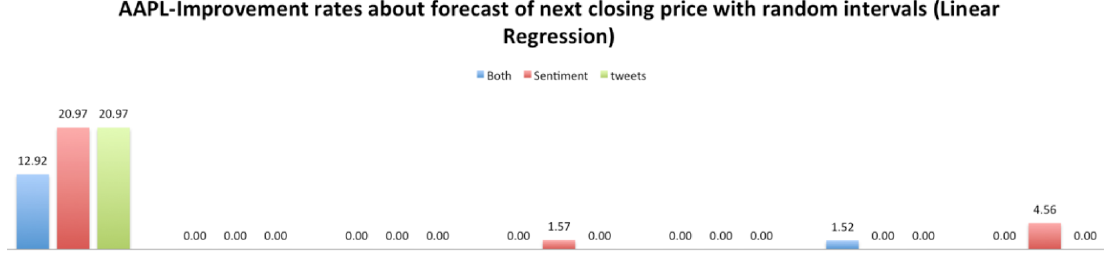
Figure 11. Improvement rates (expressed in %) at random intervals about AAPL by using linear regression.